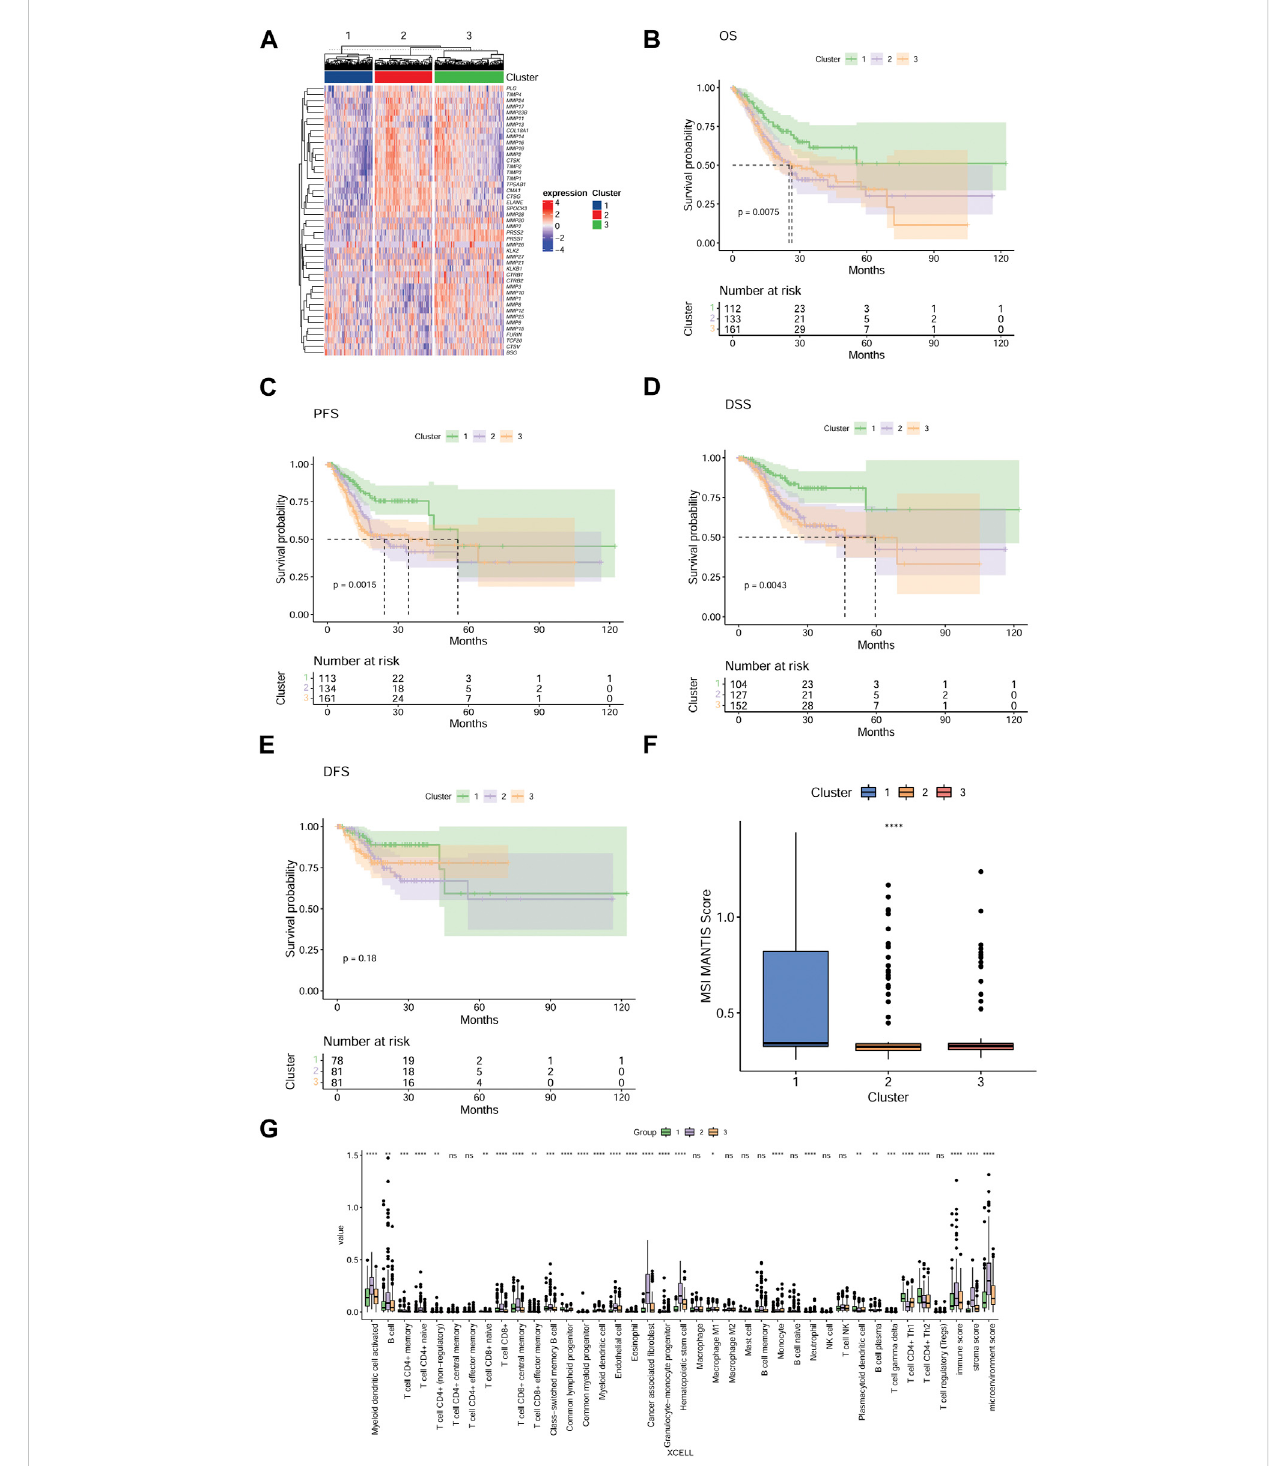
FIGURE 2 The three MMP-related groups in GC patients have signi fi cant differences in prognosis and tumor microenvironment characteristics (A) A heat map shows the expression levels of 45 MMP-related genes in three groups, and each row in the heat map represents one MMP-related gene. The degree of expressionofthegenevariesamongthethreegroups,thehighertheexpressionlevel,theredderthecolor,andthelowerthebluer.Kaplan-Meiersurvival analysis comparing the differences in OS (B) , PFS (C) , DSS (D) , and DFS (E) among the three groups of patients. (F) Box plots depict theMSI scores of thethreegroupsofpatients. (G) Boxplotsshowingdifferencesinthetumormicroenvironmentamongthethreegroupsofpatients.* p < 0.05;** p < 0.01; *** p < 0.001; **** p < 0.0001. Ns, not signi fi